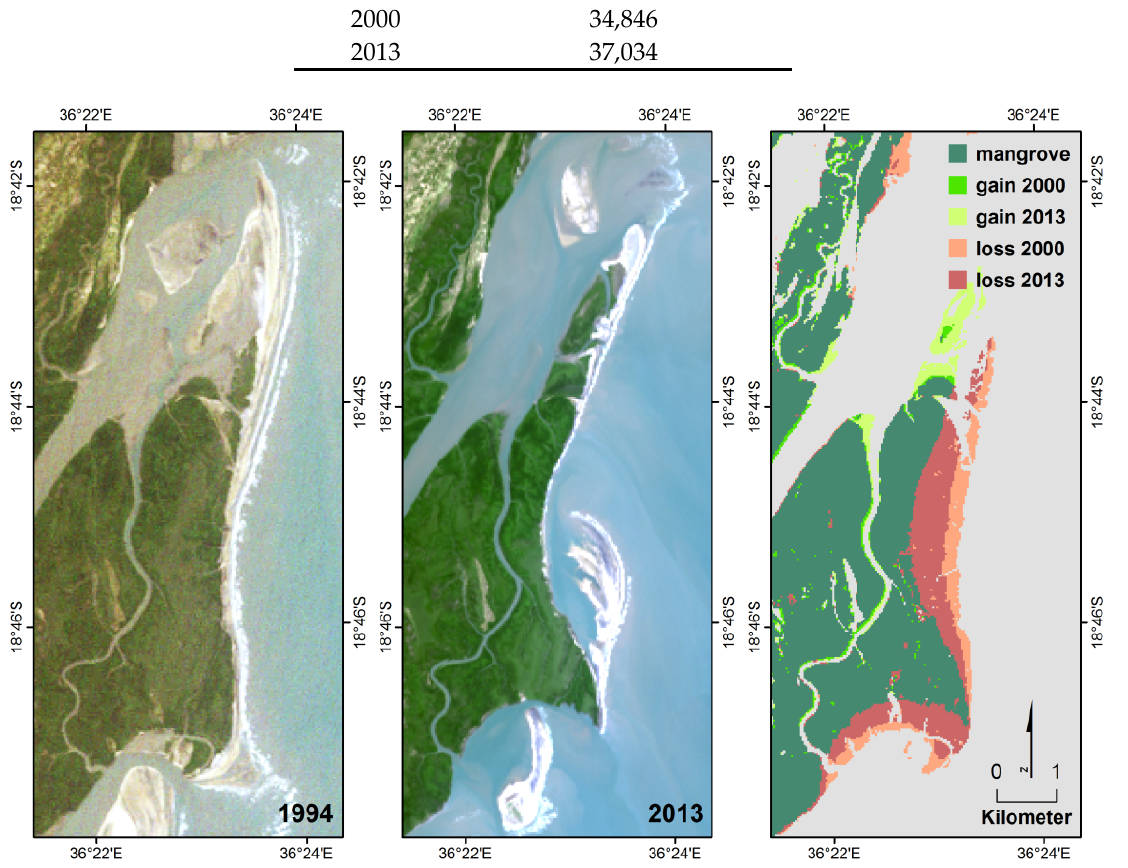
Figure 4. An area within the Zambezi River Delta which experienced extensive erosion in the coastal margin and development of new islands between 1994 ( left ) and 2013 ( middle ), areas of loss are shown in red and gain in green ( right